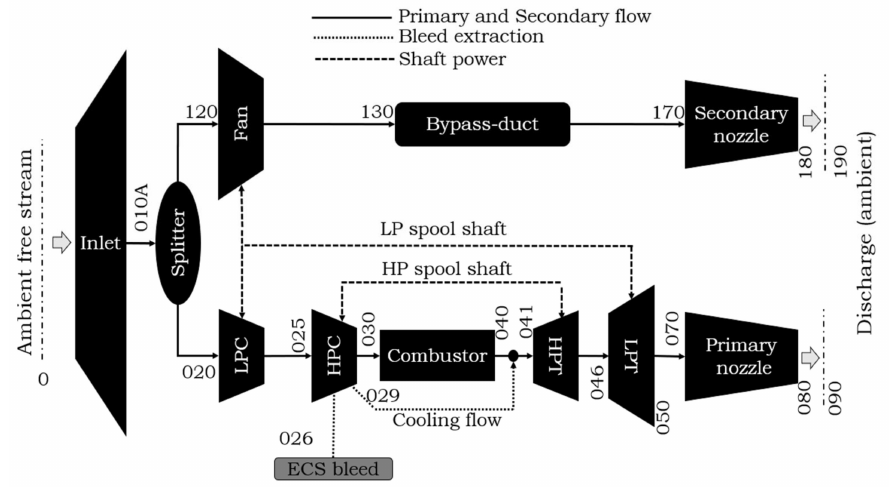
Figure 1. Turbofan model